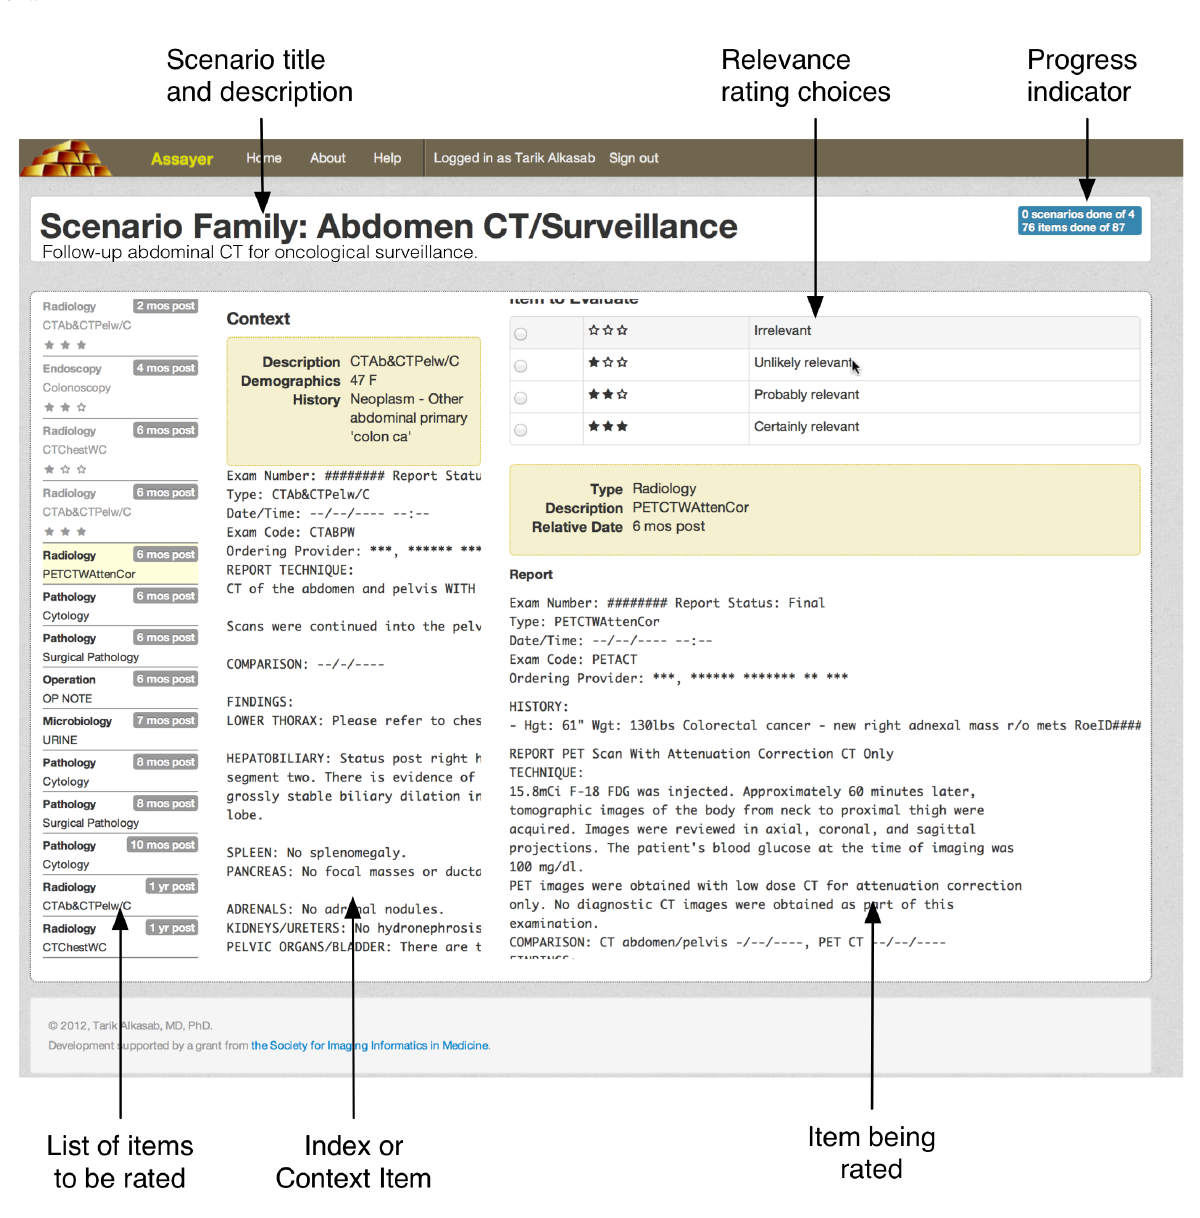
Figure 3. Expert rating interface. An expert rater considers a particular scenario family and a specific clinical context and assesses the relevance of the items in the medical record to the given scenario. Relevance is rated on a 4-step scale: irrelevant, unlikely relevant, probably relevant, and certainly